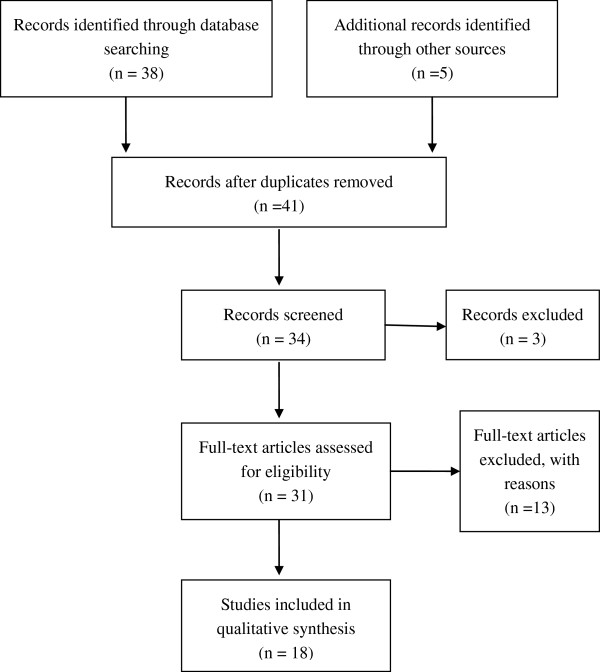
Flow chart of literature selection.